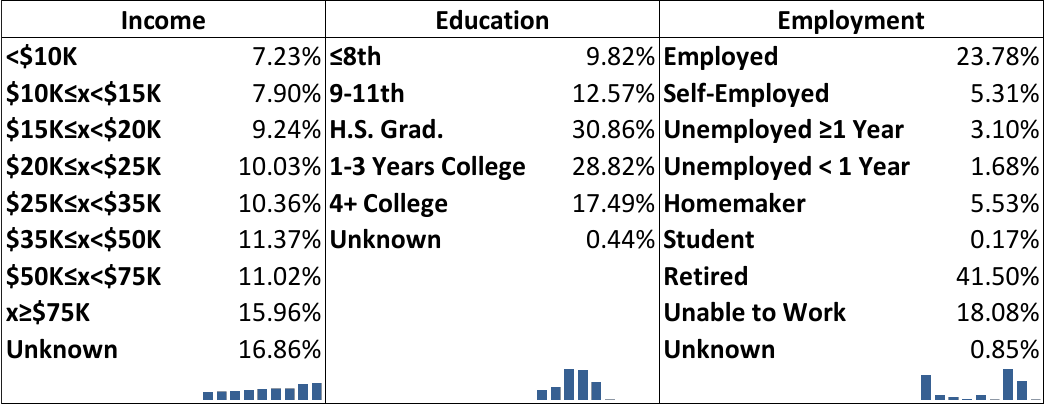
Figure 5. The marginal distributions for health status variables. 3.2. Inferential Statistics Quasibinomial regression models estimated predictors for the six dependent varia- bles. The referent categories for the independent variables were as follows: age: 45 to 54, gender: female, race: white non-Hispanic, marital status: married, education: college 4+ years, employment: employed for wages, general health: excellent, health plan: yes, per- sonal doctor: yes, checkup: yes, no money for care: no. Figure 6 and Table 2 are the forest plots and odds ratios/ p -values for the quasibinomial models.